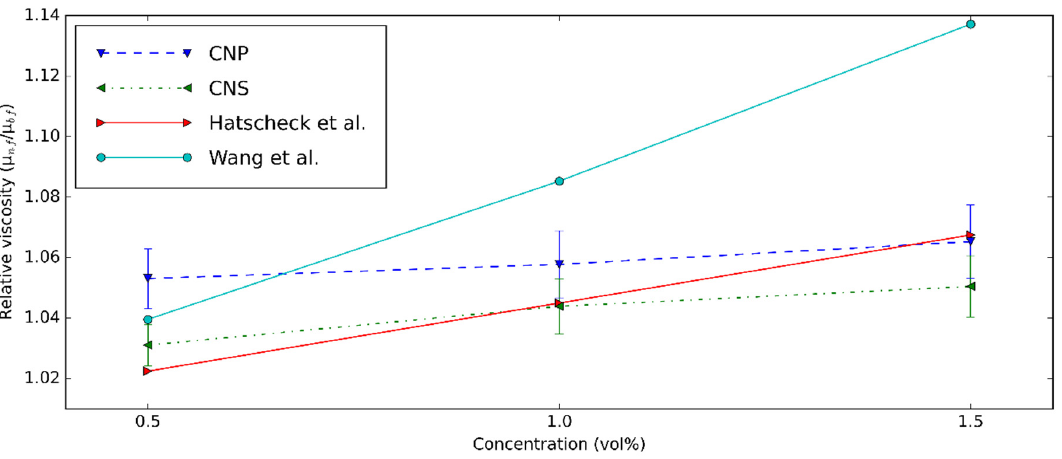
Figure 10. Relative viscosity comparison between the present study and the result of Hatscheck et al. [74] and Wang et al. [8] at 20 ◦ C and different